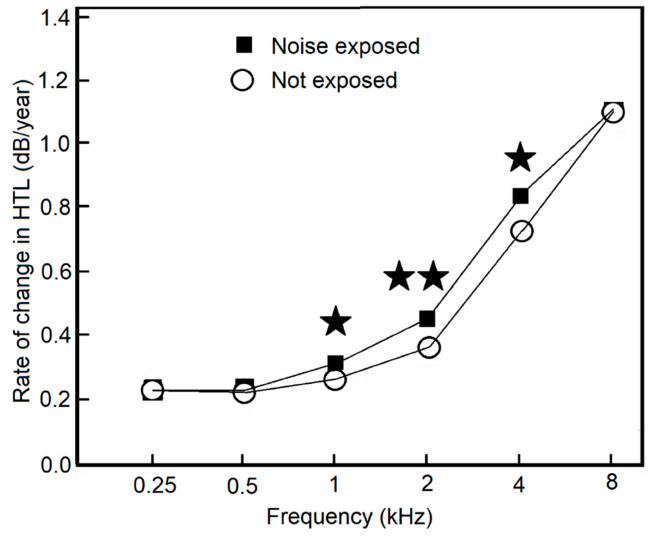
Figure 3. Rate of change of HTLs (dB/year) as a function of test frequency for Group I (exposed to noise during military service) and Group II (non-exposed control). (cid:70) and (cid:70)(cid:70) indicate p < 0.05 and p < 0.01, respectively. Redrawn from